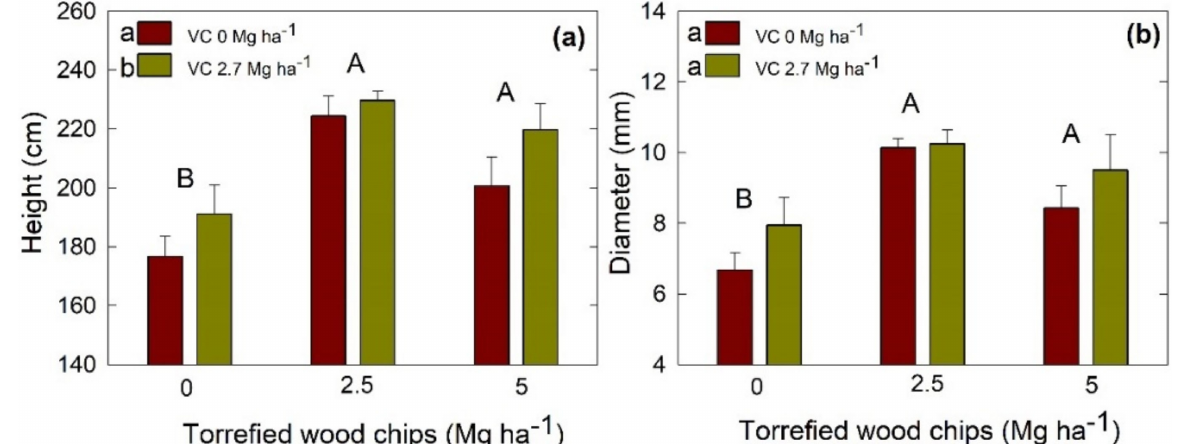
Figure 2. ( a ) Height and ( b ) diameter growth of Populus euramericana with different amendments of the TWC (torrefied wood chips) and VC (vermicompost). Different uppercase letters indicate significant differences across the TWC treatments and different lowercase letters (not enclosed by parentheses) indicate significant differences between the VC treatments. Vertical bars indicate standard errors (n = 3).